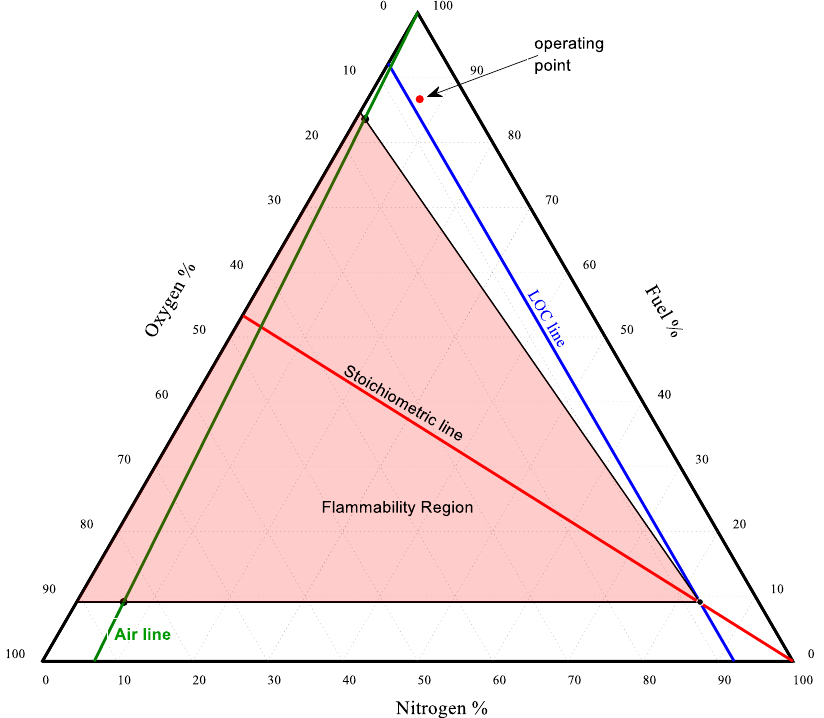
Figure 4. Fuel flammability diagram for the fuel/oxygen/nitrogen mixture at 130 °C and 2 MPa. The fuel mixture is solely composed of MeOH and CO.